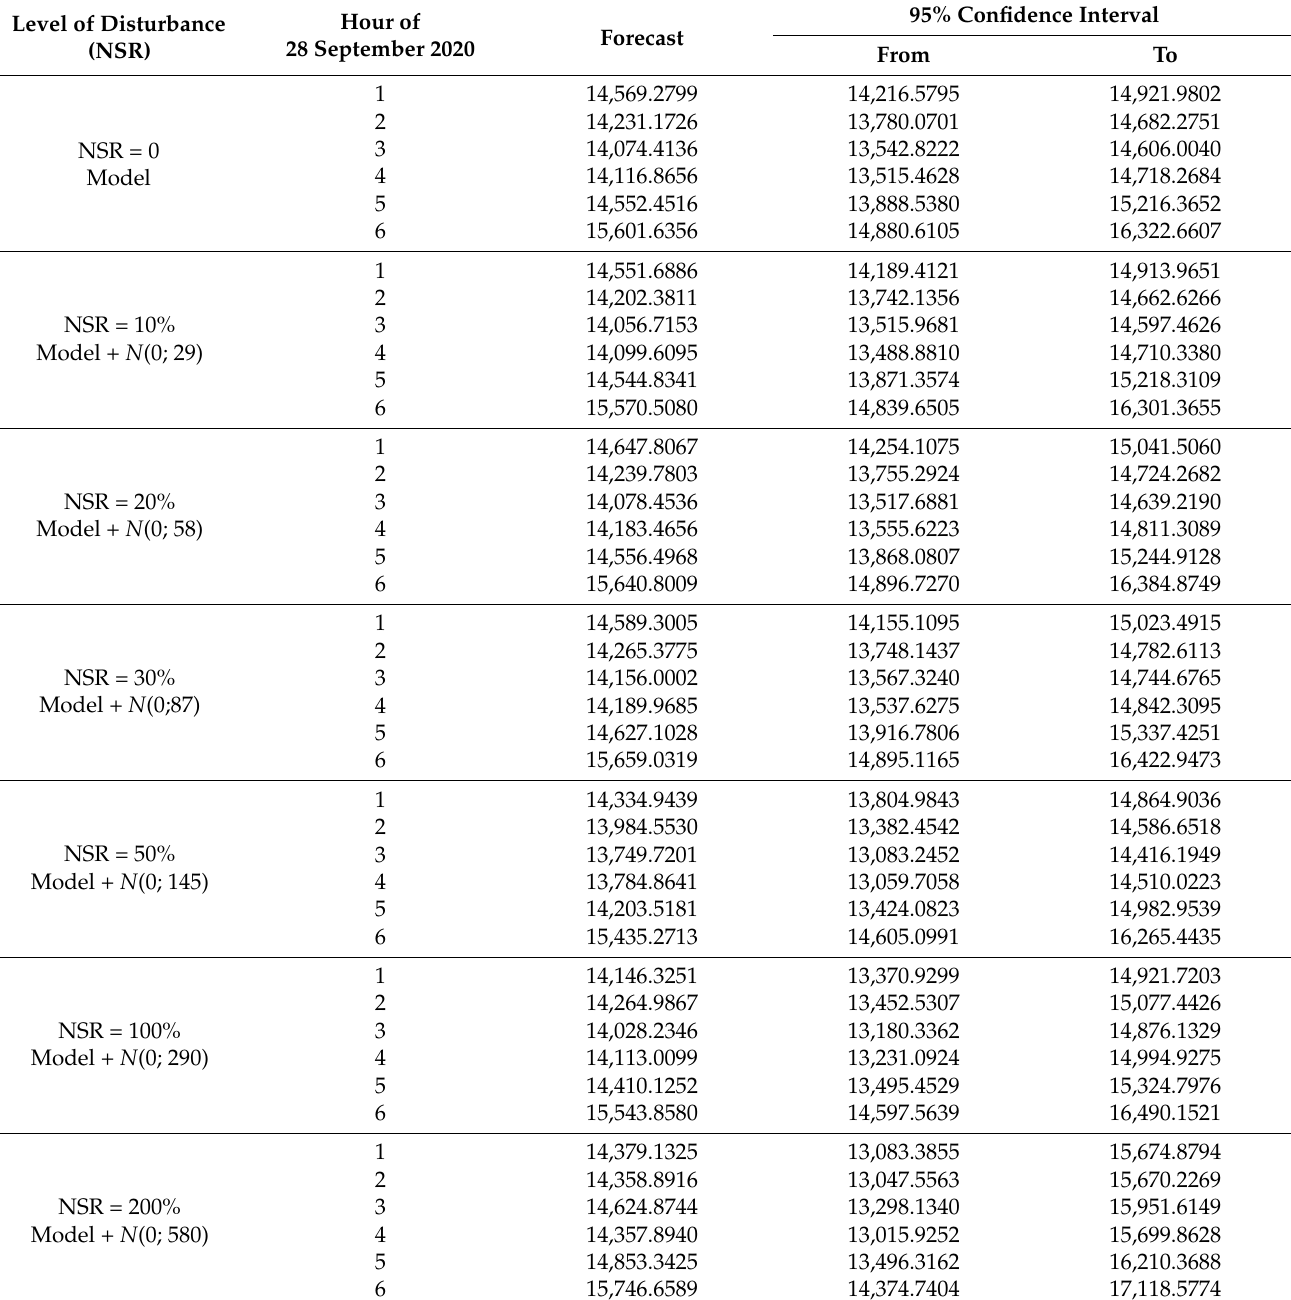
Table 5. ARIMA forecasts for the periods of 6 h ( t = 2017, 2018, 2019, 2020, 2021, 2020) for 28 September